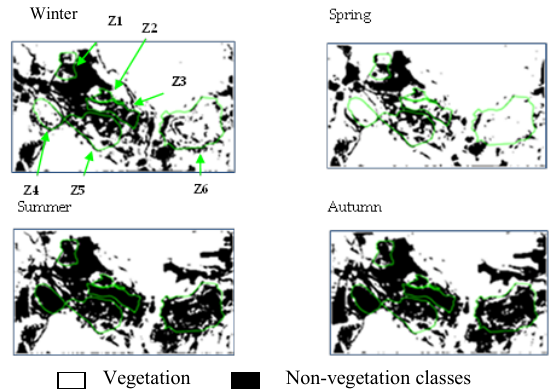
Figure 2. Temporal evolution of the vegetation cover map by season in 2017. Zones 1, 2 and 5 (named Z1, Z2, Z5) are phyto- stabilized. Zones 3, 4 and 6 (named Z3, Z4, Z6) are covered by natural vegetation.